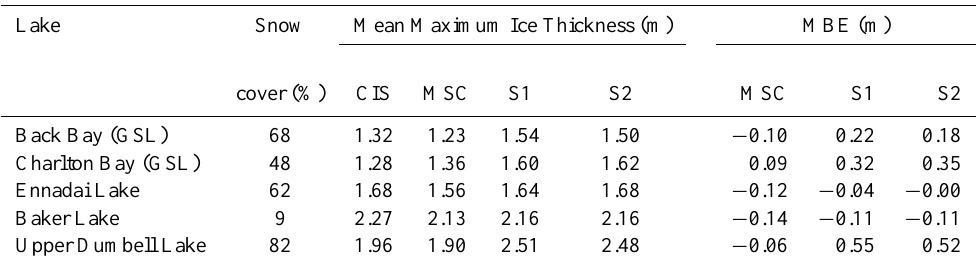
Table 4. Mean bias error in mean maximum thickness for the validation sites along with the mean maximum thicknesses (dates as indicated in Table 1).